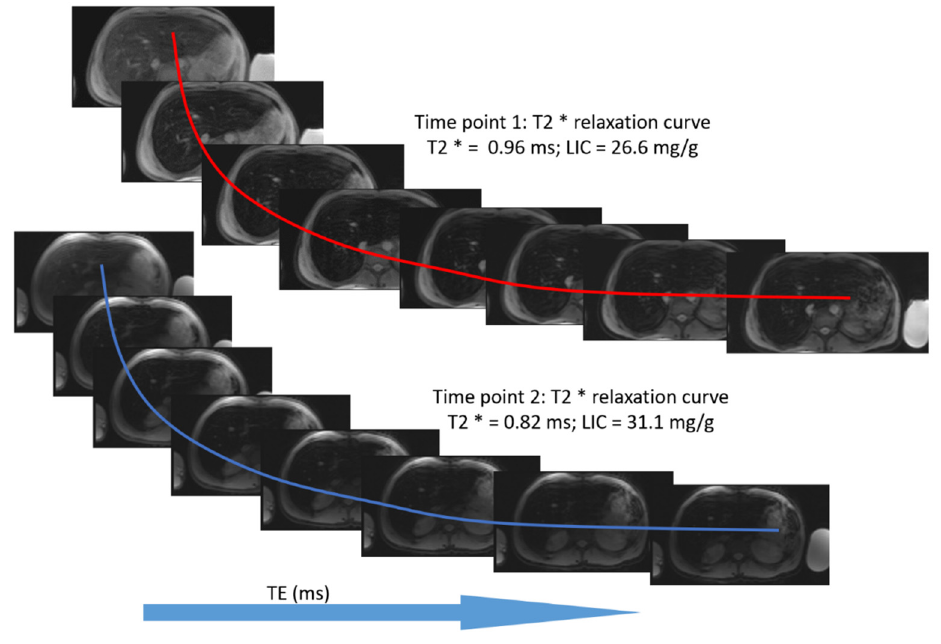
Figure 3. T2* relaxation curve for the same patient at two time points. The second scan was performed approximately two years after the first scan.